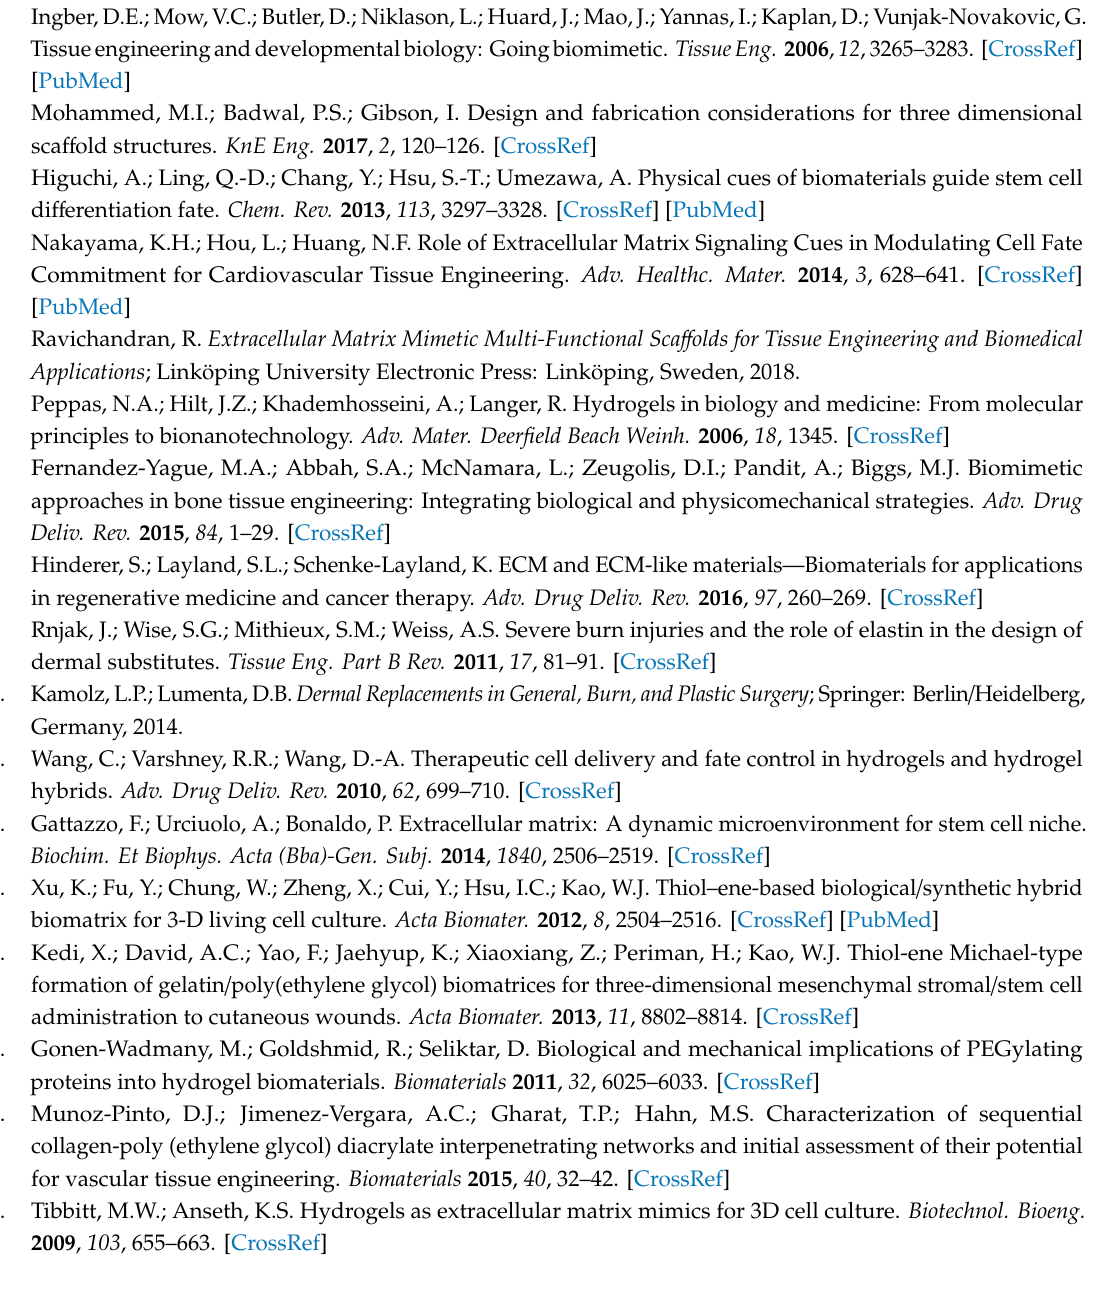
Figure S1: Immunofluorescence staining for elastin (green) and collagen type I A (yellow) in cell free GEP45, GEP30 and GPE control, Figure S2: NHDFs were encapsulated into elastin-PEG hydrogel (no gelatin-PEG-acrylate or